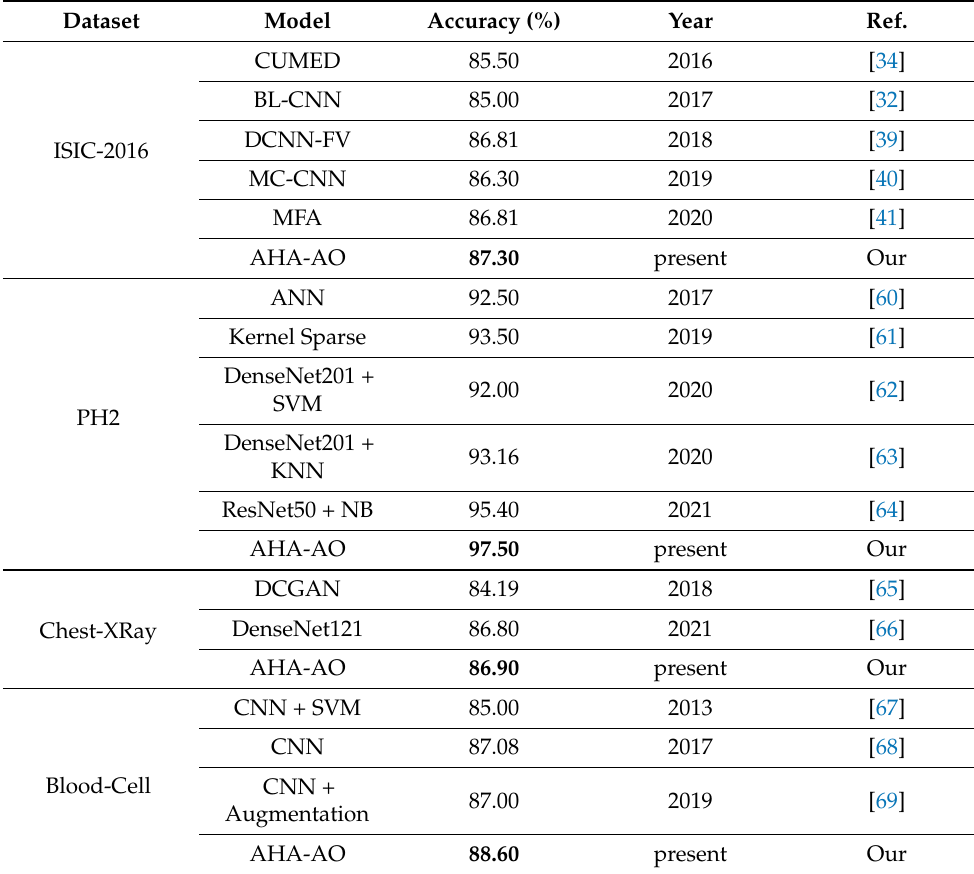
Table 8. Comparison with the state-of-the-art methods. The best results for each item are labeled in bold (bold refers to best